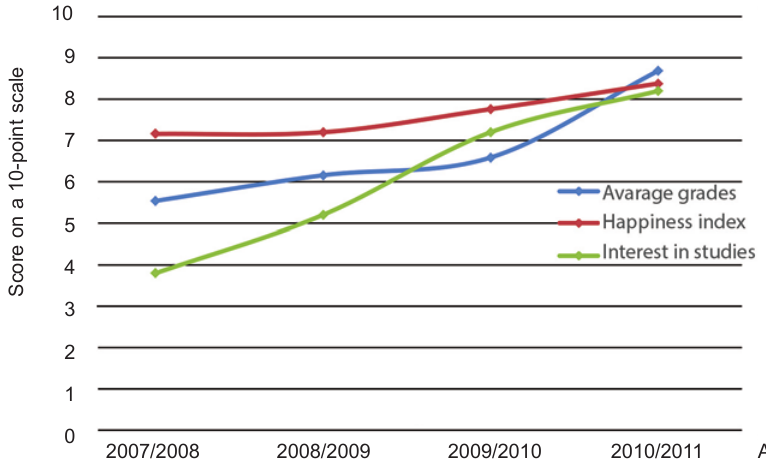
Figure 1. Variation of the happiness index, degree of interest in studies and the average grades throughout the